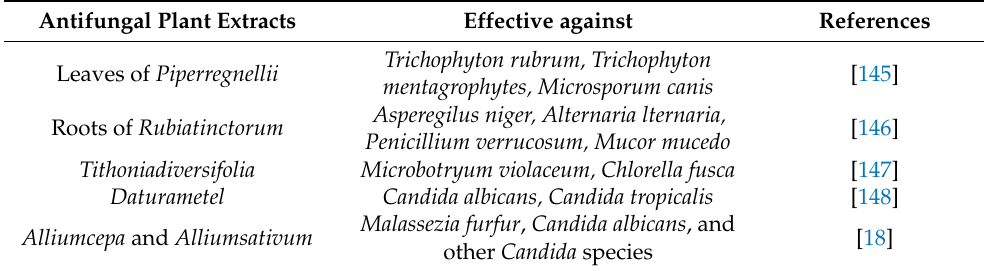
Table 8. Plant extracts having antifungal